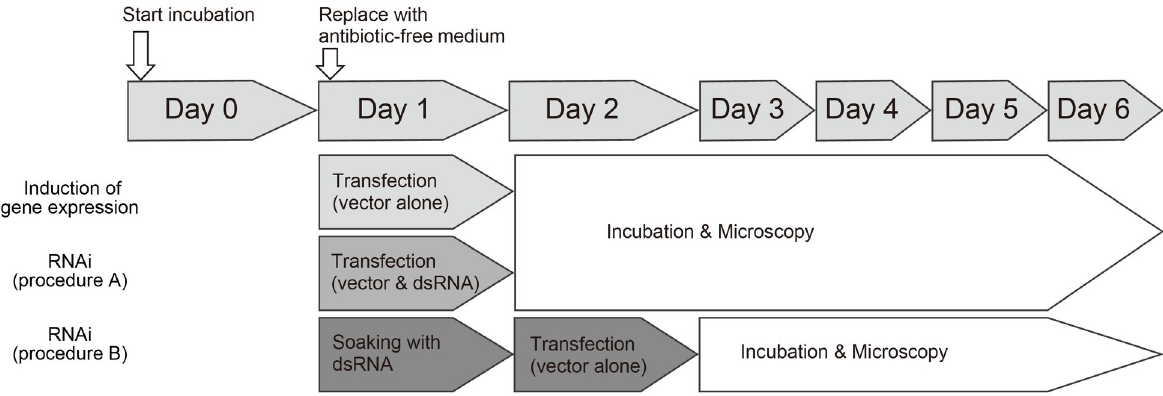
Fig 2. Manipulation timeline of the ex vivo cell culture. Days after incubation were referred to as Day 0, Day 1, Day 2, and thereafter. The cells on each day after the incubation were referred to as Day 1 cells, Day 2 cells, Day 3 cells, and thereafter. Experimental procedures for the induction or inhibition of gene expression are described below the time course. To induce gene expression, the expression vector plasmid was transfected into cells on Day 1. To inhibit gene expression (RNAi, procedure A), a mixture of the expression vector plasmid and dsRNA was transfected into cells on Day 1. In another procedure to inhibit gene expression (RNAi, procedure B), cells were incubated with dsRNA-containing culture medium on Day 1, incubated for one day, and the expression vector plasmid was then transfected into cells on Day 2.